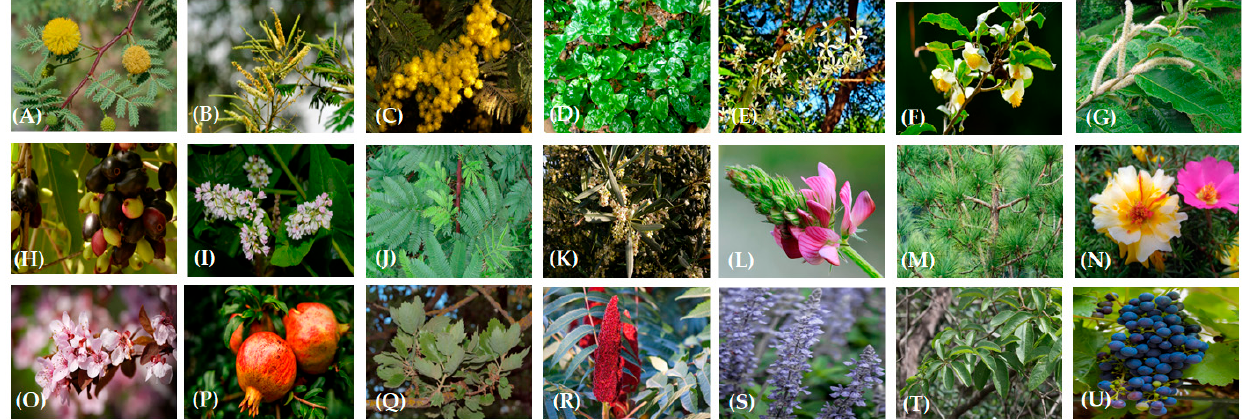
Figure 4. Examples of plant sources whose polyphenolic extracts are of broad interest in investigations focused on their ability to affect rumen fermentation parameters. ( A ) Acacia arabica ; ( B ) Acacia catechu ; ( C ) Acacia dealbata ; ( D ) Alternanthera sissoo; ( E ) Azadirachta indica; ( F ) Camellia sinensis; ( G ) Castanea mollissima; ( H ) Eugenia jambolana; ( I ) Fagopyrum esculentum; ( J ) Mimosa tenuiflora; ( K ) Olea europaea; ( L ) Onobrychis viciifolia; ( M ) Pinus radiata; ( N ) Portulaca oleracea; ( O ) Prunus cerasifera; ( P ) Punica granatum; ( Q ) Quercus ithaburensis subsp. macrolepis; ( R ) Rhus typhina; ( S ) Salvia officinalis; ( T ) Schinopsis balansae; ( U ) Vitis vinifera.